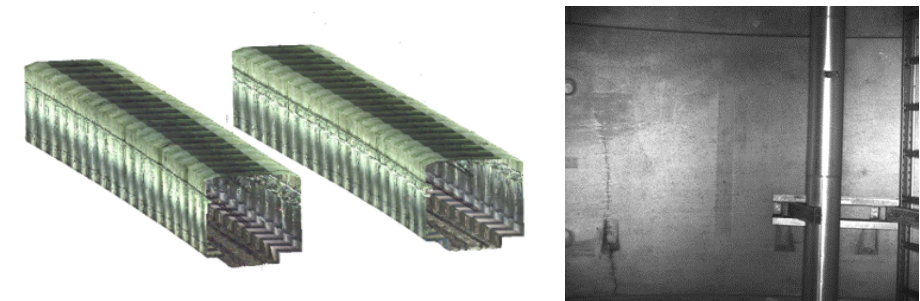
Figure 7. Tunnel data collected using WSP mobile mapping systems: LiDAR point cloud reconstruc- tion ( left ) and high-resolution image ( right